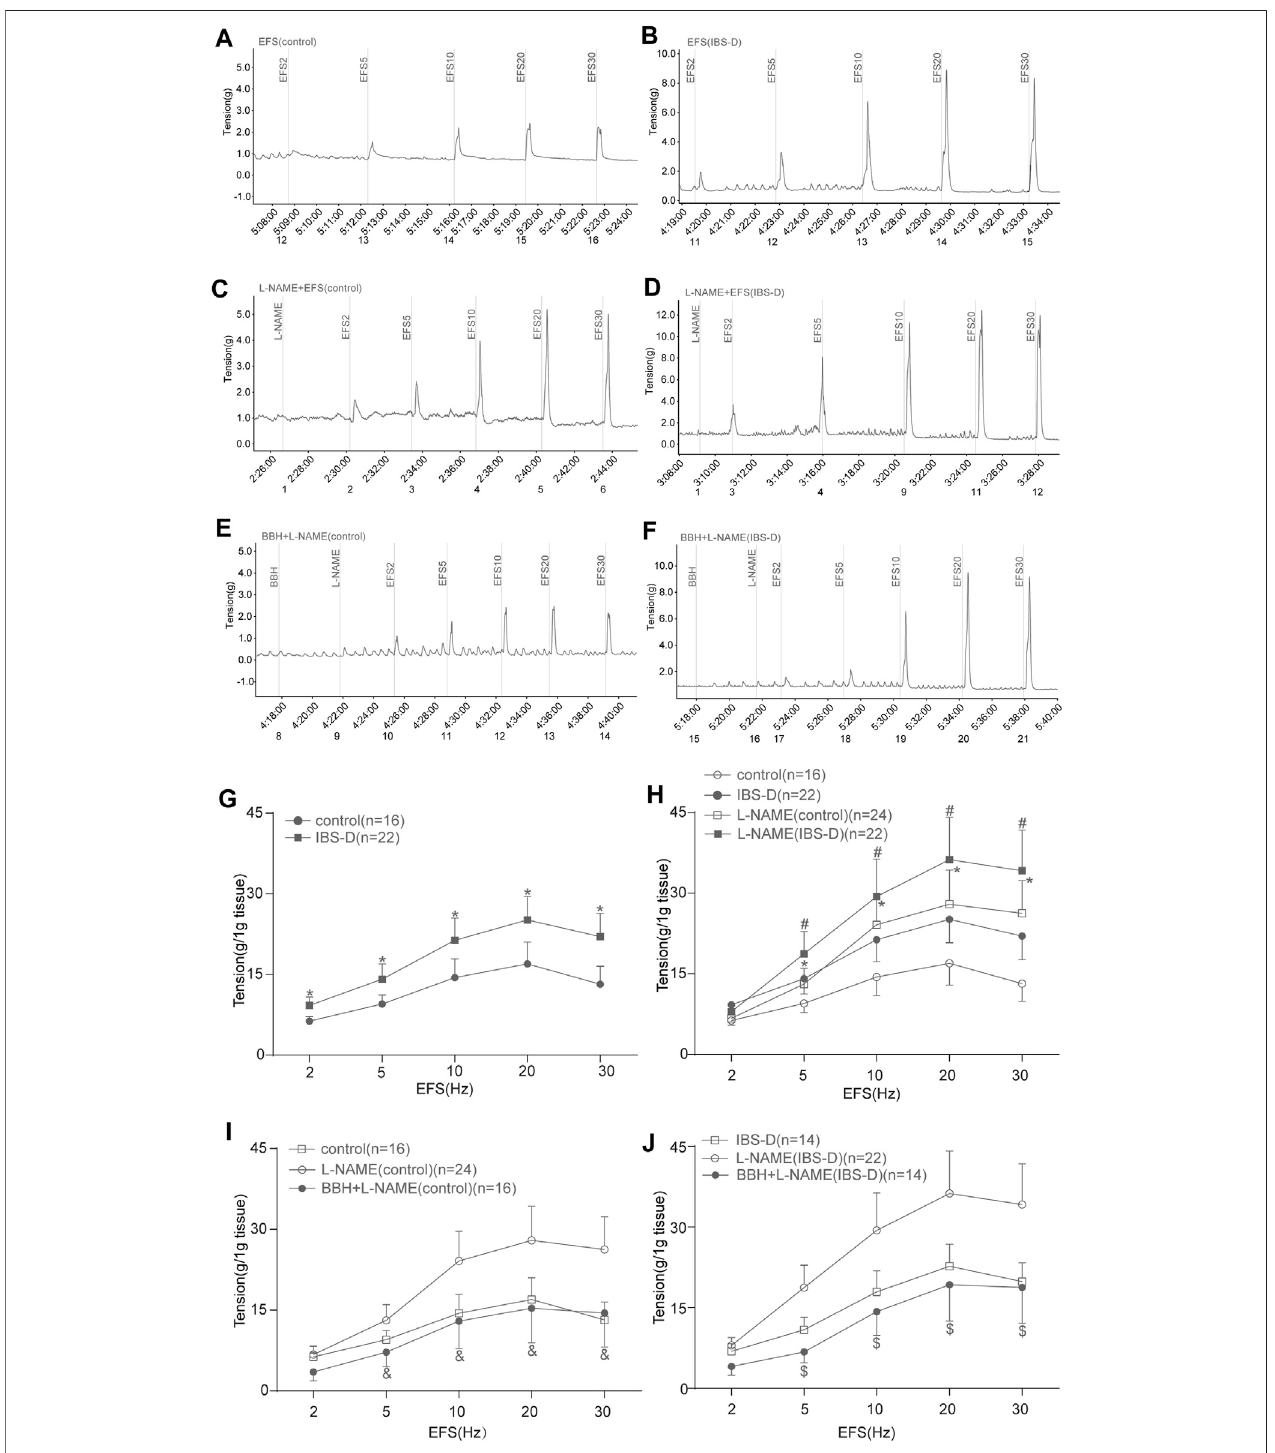
FIGURE 7 | BBH inhibited the EFS-induced nitrergic contractile responses of isolated colonic longitudinal smooth muscles. Mechanical recording (A – F) and line chart (G – J) oftheeffect ofL-NAMEand BBH+ L-NAMEtreatmentsonthe EFS-induced contractionresponseofcolonic longitudinalsmooth musclesin thecontroland IBS-Dgroups. (A) :EFS-inducedcontrolgroup( n (cid:2) 16) (B) :EFS-inducedIBS-Dgroup( n (cid:2) 22) (C) :L-NAME-inducedcontrolgroup( n (cid:2) 24). (D) :L-NAME-inducedIBS-D group ( n (cid:2) 22). (E) : BBH + L-NAME-induced control group ( n (cid:2) 16). (F) : BBH + L-NAME-induced IBS-D group ( n (cid:2) 14). (G) : EFS-induced contractile responses in thecontrolandIBS-Dgroups.*denotes p < 0.05comparedwiththeEFS-inducedcontrolgroup. (H) :EFS-inducednitrergiccontractileresponsesinthecontrolandIBS- D groups. * denotes p < 0.05 compared with the EFS-induced control group; # denotes p < 0.05 compared with the EFS-induced IBS-D group. (I) : BBH inhibited the EFS-induced nitrergic contractile responses in the control groups & denotes p < 0.05 compared with the L-NAME-induced control group. (J) : BBH inhibited the EFS- induced nitrergic contractile responses in the IBS-D groups. $ denotes p < 0.05 compared with the L-NAME-induced IBS-D group. Error bars represent mean ± SEM.